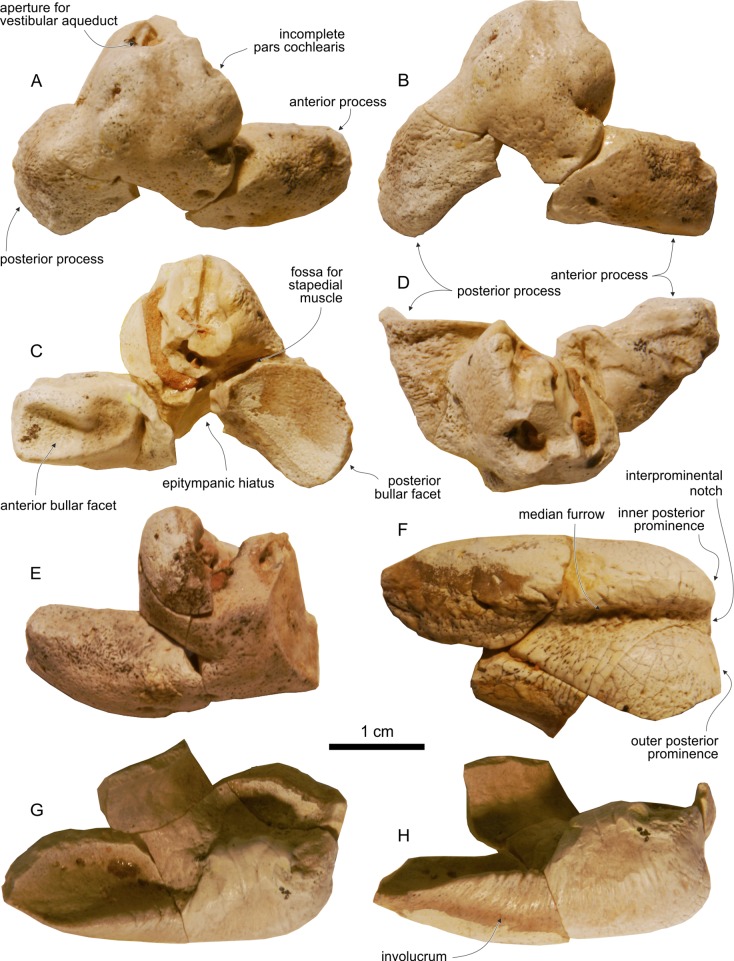
Periotics and tympanic bulla of Genus and sp. indet. 1 (MUSM 3237), from the Tortonian of Cerro Los Quesos (Pisco Basin, Peru): right periotic in (A) dorsal, (B) dorsomedial, (C) ventral, and (D) medial views; (E) fragmentary left periotic in dorsal view; right tympanic bulla in (F) ventral, (G) dorsal, and (H) medial view.